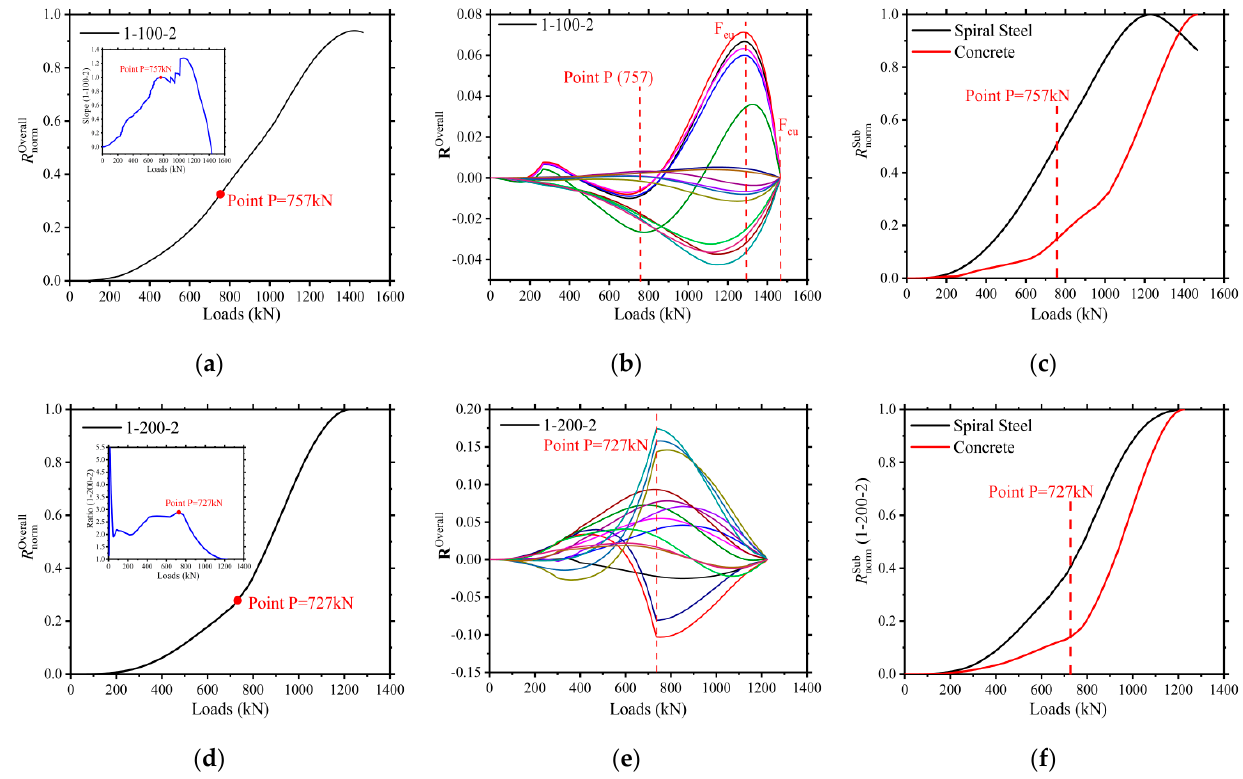
Figure 5. Mutation of SRC test’s related characteristic pair: ( a ) Correlation parameter of 1-100-2; ( b ) Correlation mode of 1-100-2; ( c ) Correlation parameter of components; ( d ) Correlation parameter of 1-200-2; ( e ) Correlation mode of 1-200-2; ( f ) Correlation parameter of components.